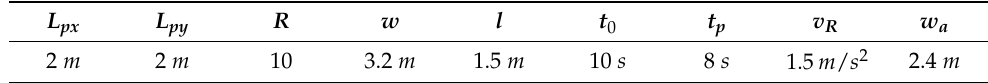
Table 2. System setting parameters in simulation.